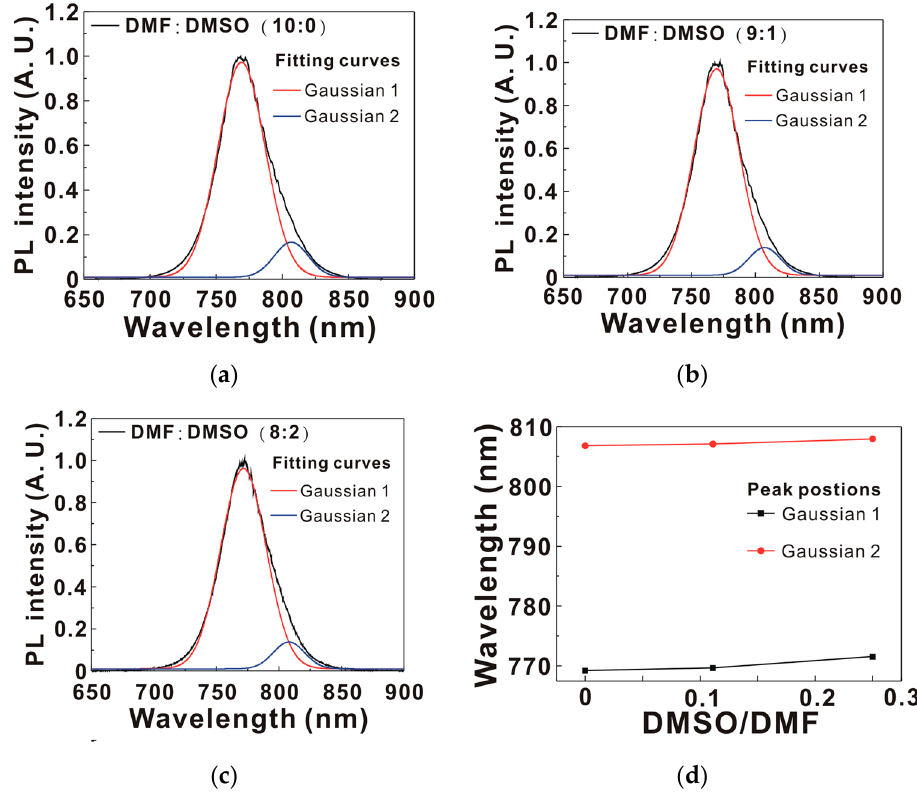
Figure 6. ( a – c ) The normalized PL spectra of the MAPbI 3 /C 60 /ITO/glass samples; ( d ) the peak emission wavelengths of the MAPbI 3 /C 60 /ITO/glass samples.